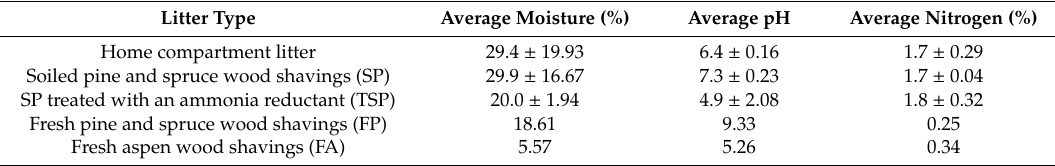
Table 1. The average moisture content (%), pH, and nitrogen (%) concentration of litter samples taken from the home compartment, as well as the four treatment litters. Home litter and soiled shavings were sampled at the start and end of the experiment, while ammonia reductant shavings were sampled at the beginning and end of the projected chemical saturation point (7 days). As fresh pine and spruce and fresh aspen litters were renewed each day only one sample was taken from these